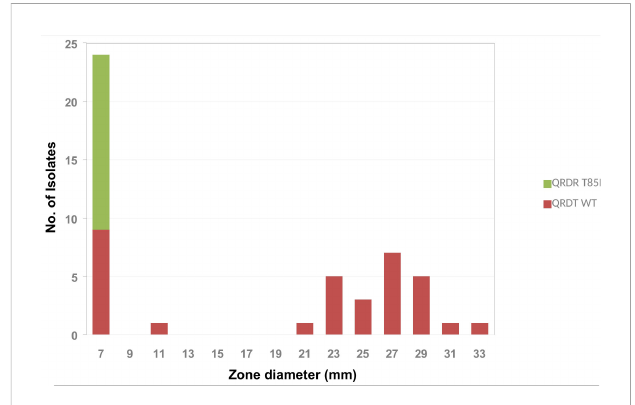
FIGURE 5 Frequency distribution of the T85I point mutation in the quinolone resistance determining region (QRDR) by cipro fl oxacin inhibition zone diameter within A. butzleri isolates tested.